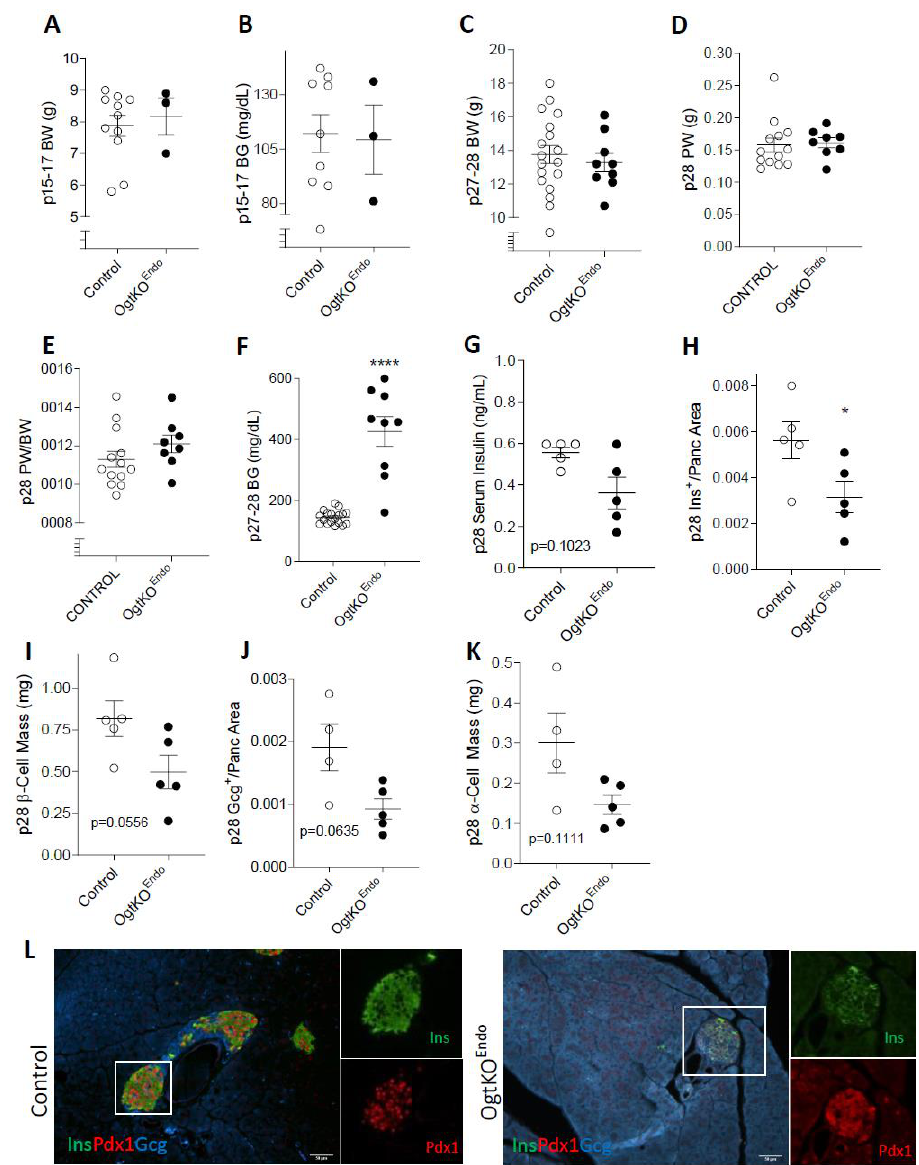
Figure 2. Progressive hyperglycemia and reduced Pdx1 Immunoreactivity in male OgtKO Endo . Body weight ( A , n = 3 – 11) and random blood glucose ( B , n = 3 – 11) at p15-17. Body weight ( C , n = 9 – 18), pancreas weight ( D , n = 8 – 13), and pancreas weight corrected over body weight ( E , n = 8 – 13, p = 0.1403) at p28. Non-fasting blood glucose levels in OgtKO Endo ( F , n = 9 – 18, **** p < 0.0001) and serum insulin ( G , n = 5, p = 0.1023) at p28. Quantification of Ins + area/pancreas area ( H , n = 5, * p = 0.0317), β -cell mass ( I, n = 5, p = 0.0556), Glucagon + area/pancreas area ( J, n = 4 – 5, p = 0.0635), and α -cell mass ( K , n = 4 – 5, p = 0.1111) at p28. Representative immunofluorescence images of cytoplasmic Pdx1 expression in OgtKO Endo ( L , 20×, scale = 50 μ m). Statistics were performed with a Mann – Whitney U-Test (two-tailed with significance p ≤ 0.05). In all graphs, open circle = Control and closed circle = OgtKO Endo . Female data in supplemental.